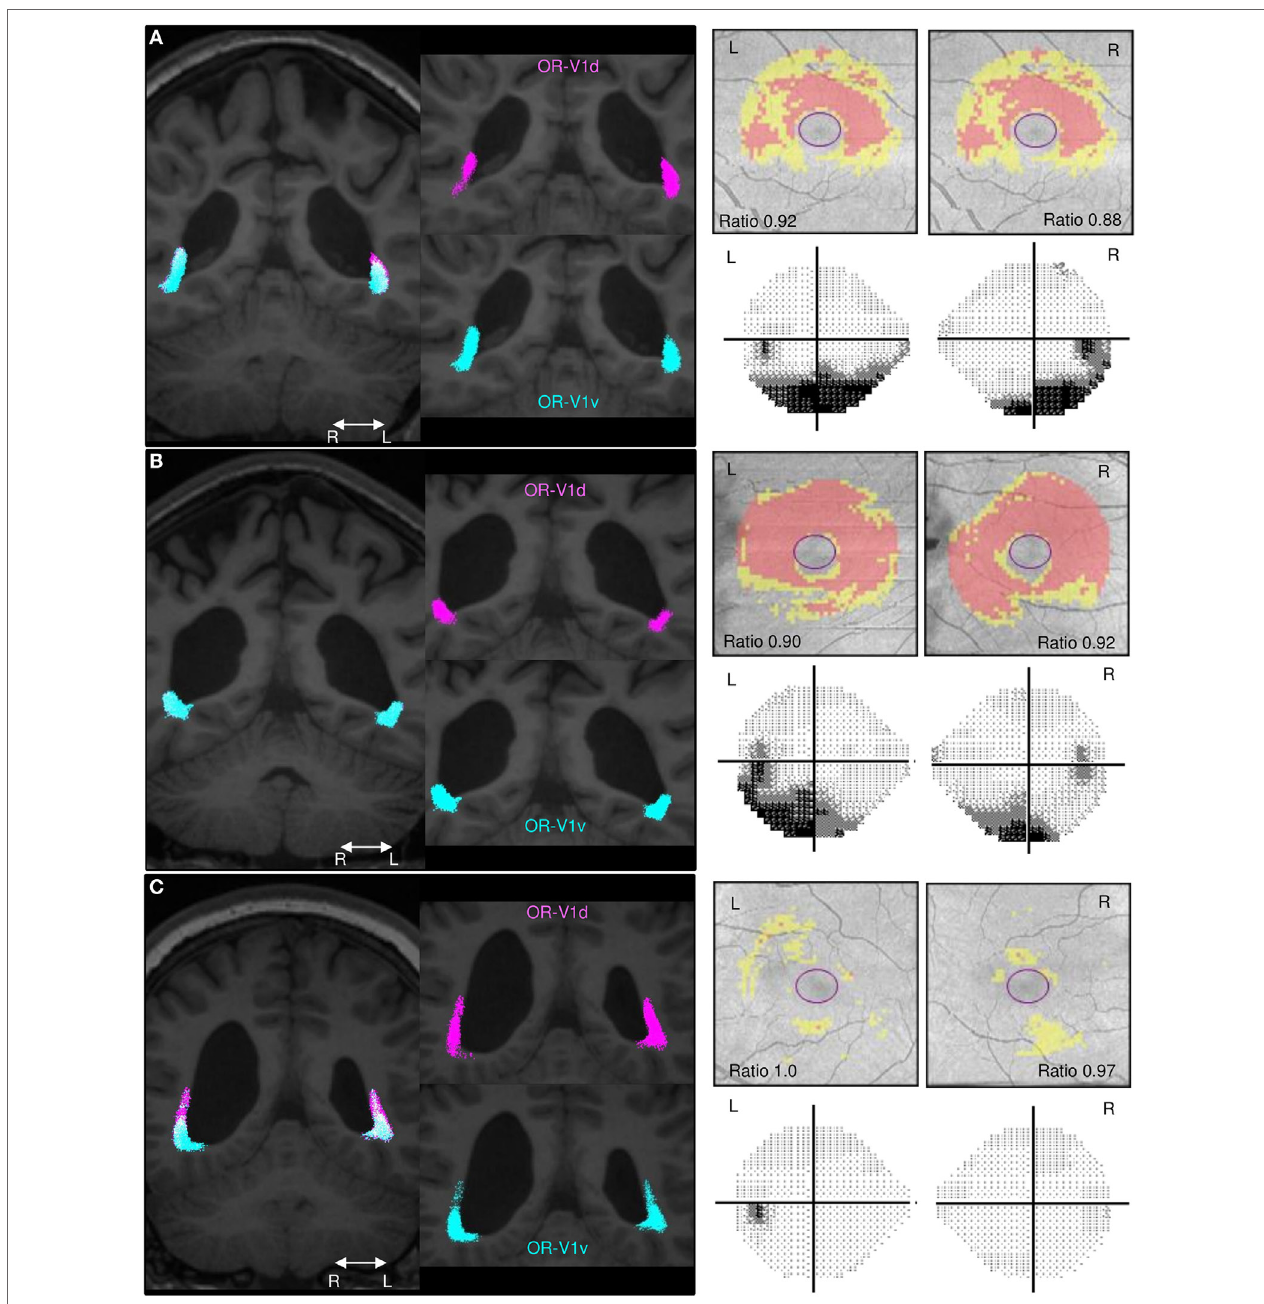
FigUre 2 | Comparison of the spatial distribution of streamlines in the OR, the GCL_IPL measurements and the VF maps. Spatial distribution of streamlines in the OR-V1d (pink) and OR-V1v (turquoise) tracts for patients. (a) Subject A, (B) Subject C, and (c) Subject G and their corresponding GCL_IPL measurements and visual field (VF) maps. Left column: tracts overlaid on 3D-T1w images in a coronal section at the level of the trigone. Right column: maps of the macular GCL_IPL thickness topography with yellow indicating minor thinning and red more severe thinning. The ratios of the average GCL_IPL thickness in superior and inferior sectors are inserted. VF maps assessed with Humphrey field analyser. The grayscale runs from white to black, with more intense darkness illustrating deeper sensitivity reduction. Grayscale printouts illustrate the reduced sensitivity in the inferior hemifield, typical for this study group. Note the topographical correspondence between the spatial displacement of the OR-V1d tract into the space occupied by the OR-VRv tract in (a) Subject A and (B) Subject C and the relative thinning of superior sectors of the GCL_IPL and inferior VF defects. This is not the case in (c) Subject G. Despite having a large white-matter damage of immaturity [bilateral intra-ventricular hemorrhage (L > R) and right-sided periventricular hemorrhagic infarct (36)], the primary visual system is not affected in this patient. Abbreviations: R, right; L, left.